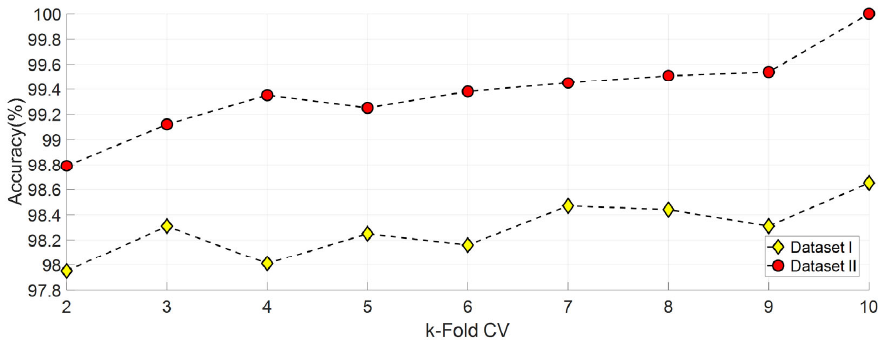
Diagnostics 2022 , 12 , x FOR PEER REVIEW